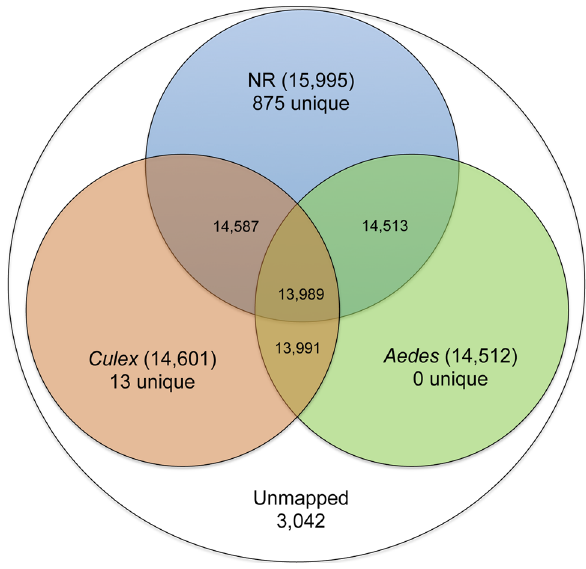
Figure 2. Unigene BLASTx alignment to the nr protein database, and Aedes or Culex gene set. The number of translated Culicoides sonorensis unigene alignments that have matches to the databases are shown. Unique numbers show how many Culicoides matches were unique to each of the databases, and the unmapped genes had not homology matches in any of the